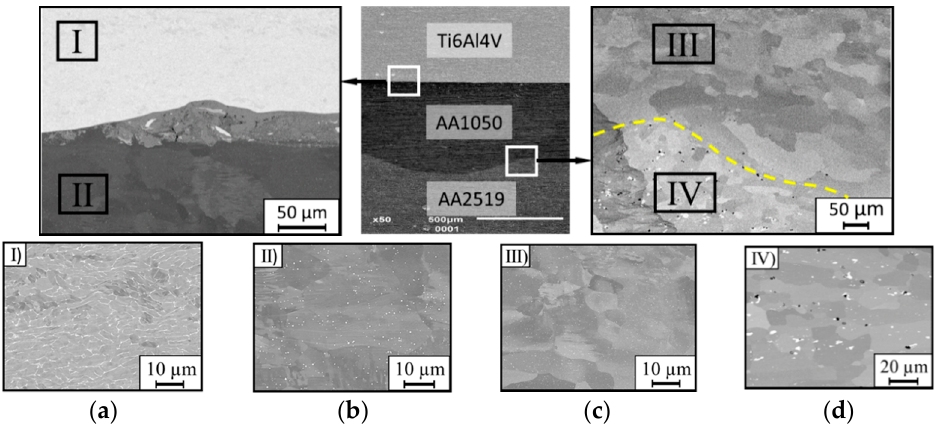
Figure 9. Metallographic cross-section of the produced explosive welded sheet of AA2519-Ti6Al4V with interlayer of AA1050 after heat treatment: ( a ) sector I–Ti6Al4V alloy; ( b ) sector II–AA1050; ( c ) sector III–AA1050; ( d ) sector IV–AA2519 alloy.